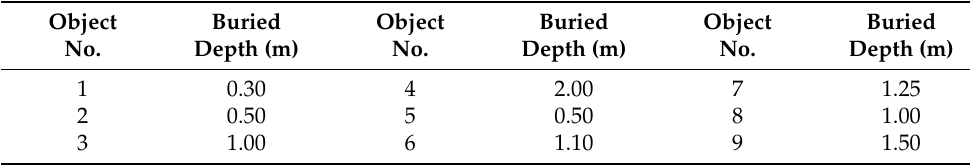
Table 2. The Rough Depth of Buried Objects in the Volcanic Ash.